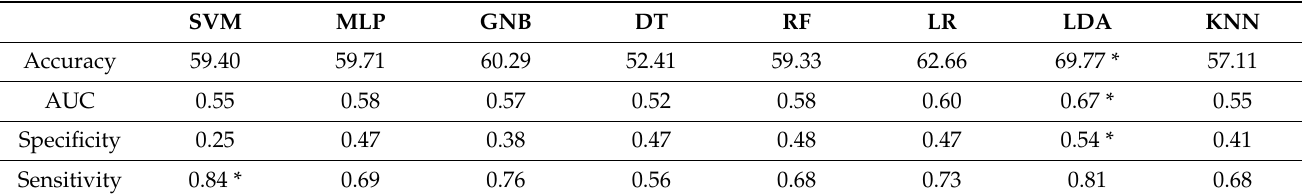
Table 3. Results of ML analysis (eight methods) for BPW indices in discriminating between Groups N and CV using pulse indices as features. Accuracies are presented as percentages. Threefold cross- validation values are listed. “*” denotes the highest average value. Among the eight methods, LDA had the highest accuracy and AUC (area under receiver operating characteristic curve).